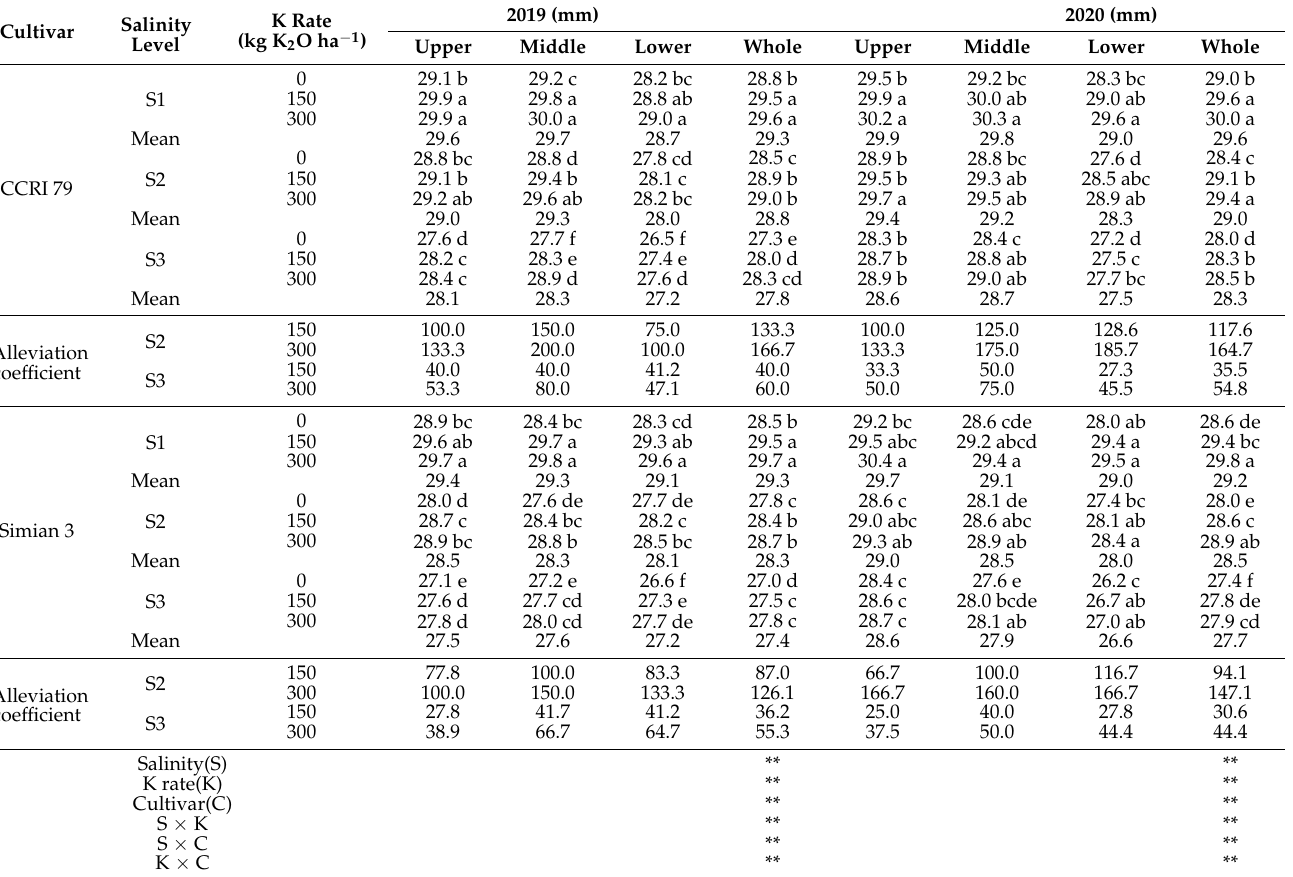
Table 3. The effect of K applications on fiber length and their alleviation coefficients under salt